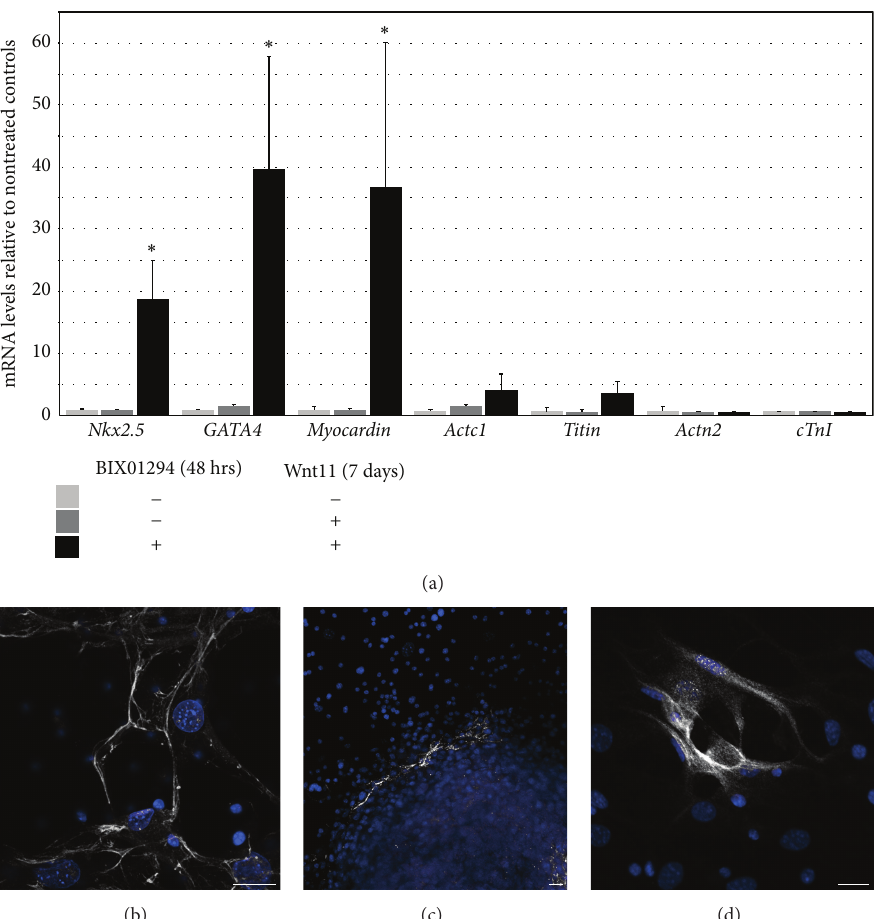
Figure 3: BIX01294 promotes responsiveness to the cardiogenic stimulating protein Wnt11. MSCs were cultured nontreated or with 8 𝜇 M BIX01294 for 48 hrs prior to seven-day culture in fresh media with or without Wnt11. (a) Real-time qPCR analysis indicated that MSCs displayed significant upregulation of the primary cardiac transcription factors Nkx2.5 , GATA4 , and myocardin in response to Wnt11 when pretreated with BIX01294, as compared to cultures that were unexposed to BIX01294. In contrast, genes encoding for cardiac 𝛼 -actin ( Actc1 ), titin , muscle 𝛼 -actinin ( Actn2 ), and cTnI showed minimal to nondetectable increases in expression in response to BIX01294 plus Wnt11 treatments. ∗ 𝑝 < 0.01 . (b–d) However, immunofluorescent analysis did demonstrate that BIX01294 plus Wnt11 treatments promoted expression of muscle proteins (gray staining), as shown for (b) desmin and (c, d) 𝛼 -actinin. Low magnification view of 𝛼 -actinin in panel (c) illustrates that expression of muscle proteins was only displayed within small patches of cells as indicated by nuclear counterstaining with DAPI (blue). Scale bar = 20 𝜇